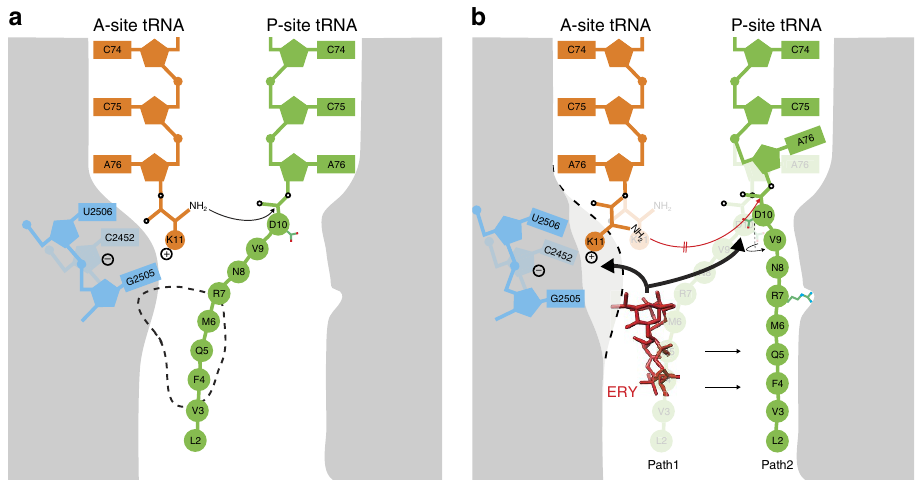
Figure 8 | Model for ErmBL-mediated translation arrest. ( a ) Canonical peptide-bond formation in absence of ERY. Here the path of the peptide (Path1) overlaps with the binding site of the drug (broken line). ( b ) Stalling in the presence of ERY. The drug restrains the conformation of the ErmBL peptide (Path2). Relative to a , the C-terminal Asp10 side chain is in a rotated position and the P-site tRNA A76 ribose is displaced. The ERY perturbs the A-site crevice nucleotides (blue), which through electrostatic interactions keeps Lys11 away from the P-site. We propose that the increased distance between the attacking amide group of the Lys11 and the carbonyl carbon of Asp10 hinders peptide-bond